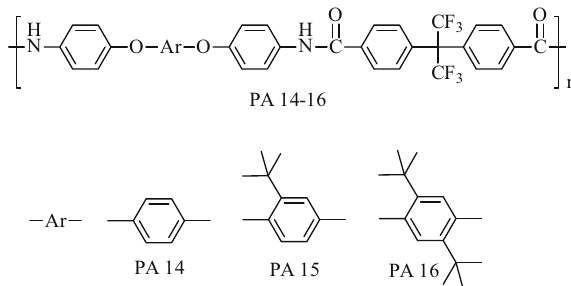
Figure 5: Structure of the PAs with varied number of bulky tert - butyl group ( 62 )